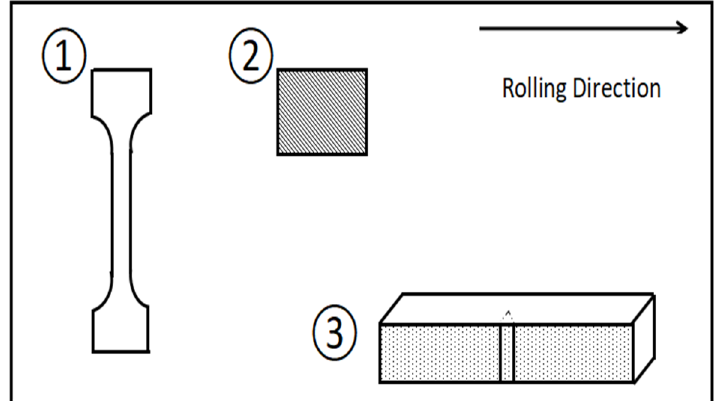
Figure 2. Schematic diagram of sampling for the performance analysis of tested steel plate. ( ① Ten- sile sample perpendicular to the rolling direction; ② Hardness and wear sample; ③ Impact sample ( 1 (cid:13) Tensile sample perpendicular to the rolling direction; 2 (cid:13) Hardness and wear sample; 3 (cid:13) Impact parallel to rolling direction. sample parallel to rolling